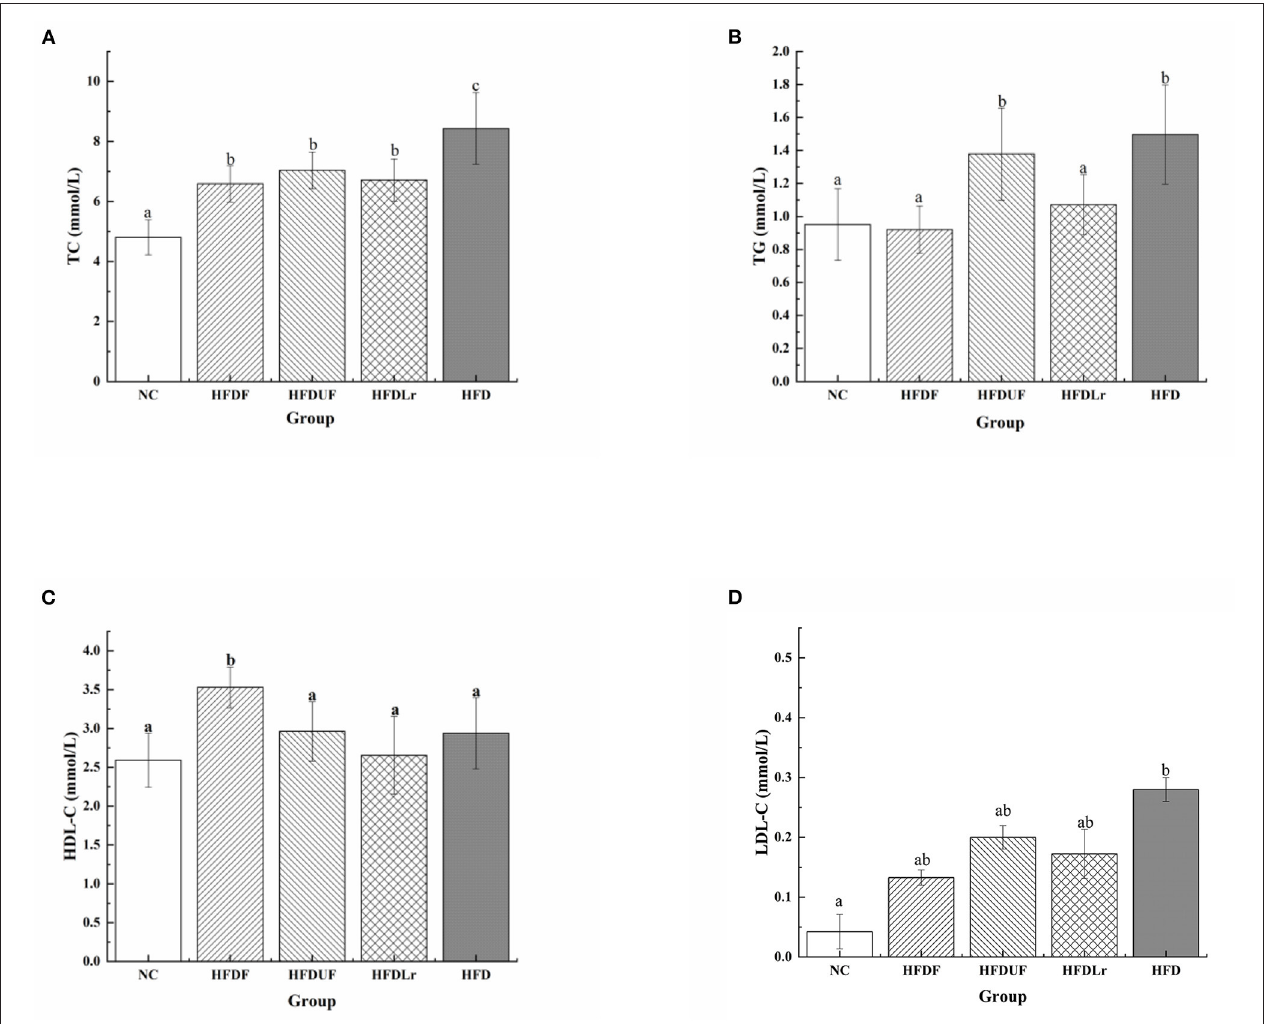
FIGURE 2 | The effects of CSM on serum lipid levels. (A) Total cholesterol (TC), (B) triglyceride (TG), (C) high-density lipoprotein cholesterol (HDL-C), and (D) low-density lipoprotein cholesterol (LDL-C). All data are expressed as the mean ± SD ( n = 10 mice/group). The statistical differences between groups were analyzed using ANOVA. A p value < 0.05 was considered statistically significant. The superscript letters indicate significant differences between